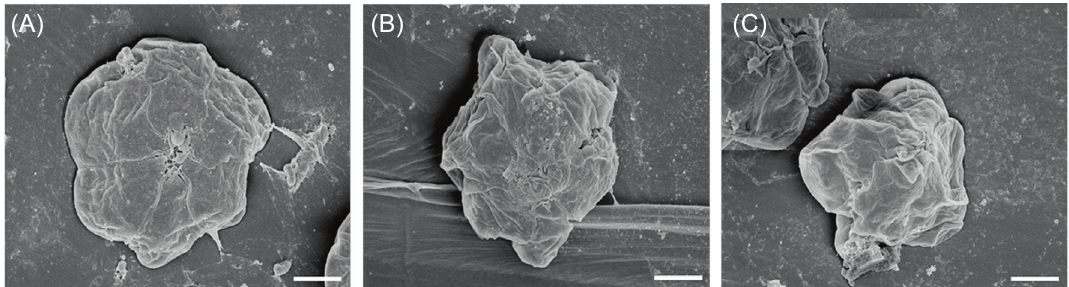
Figure 3. Scanning electron microphotographs of Kudoa septempunctata spores. (A) Untreated control; (B and C) incubated with Ampros after 48 h. Spores decreased in size and the shell valves became unstructured (B, C). Scales, 2 l m.